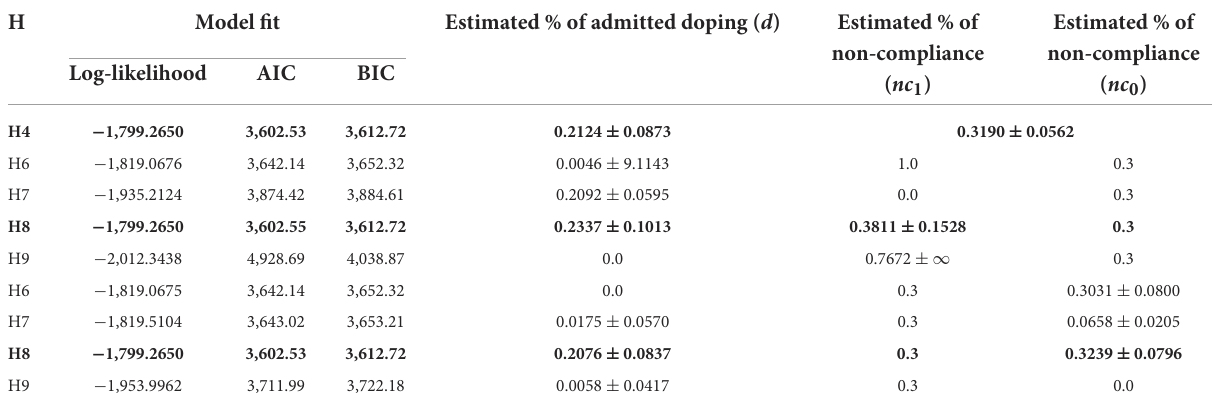
TABLE 5 Doping prevalence estimation using a dependent model for non-compliance.